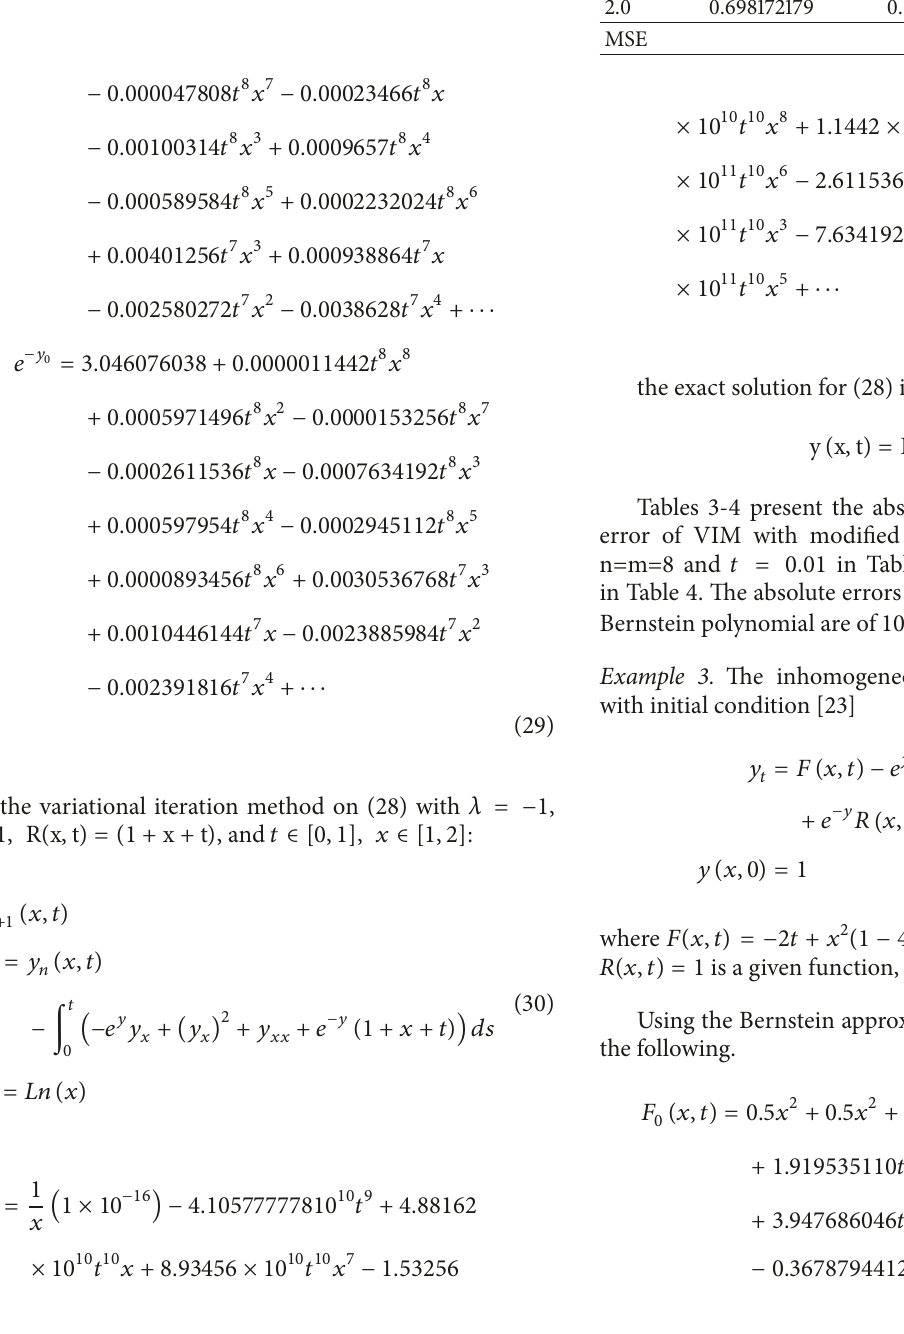
Figure 2: Absolute error for (22) using VIMB when n=m=2 and t=0.1.